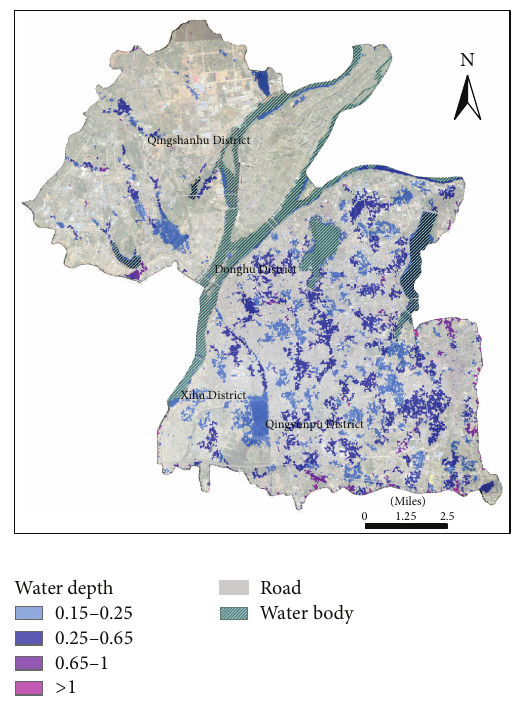
Figure 12: Distribution map of waterlogging in return period of 100 years of